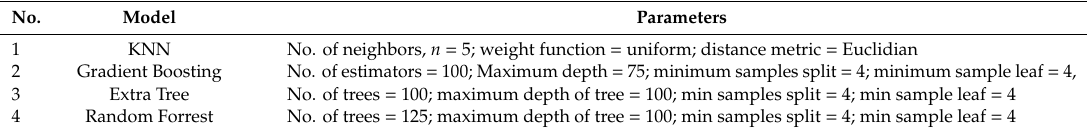
Table 3. Parameters of various machine learning algorithms